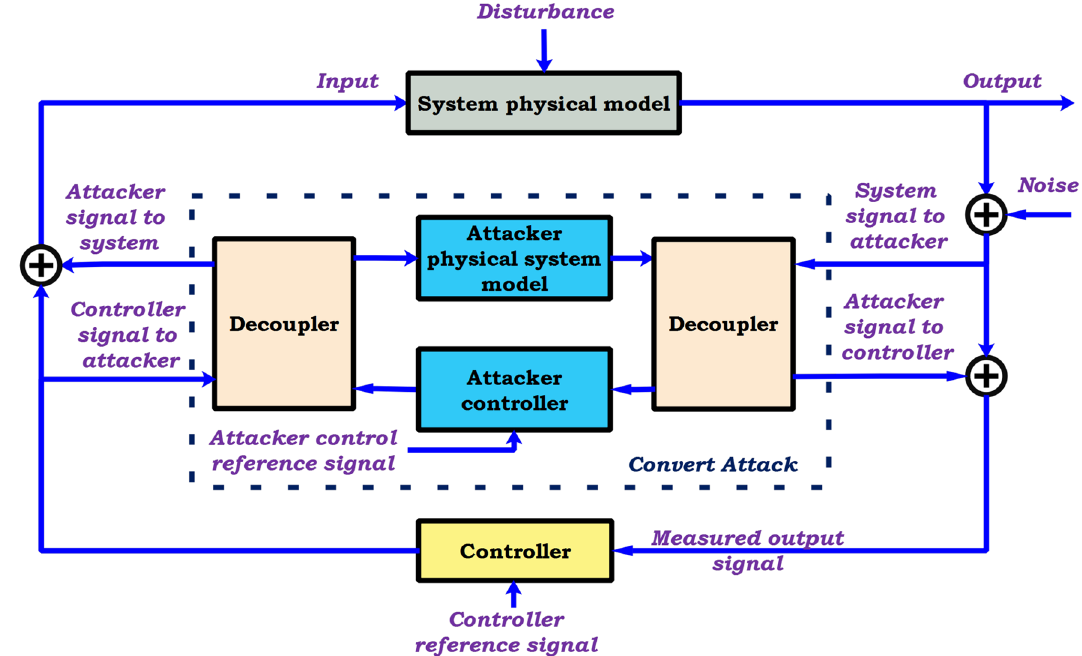
Figure 11. Stealth attack on power grid—a schematic